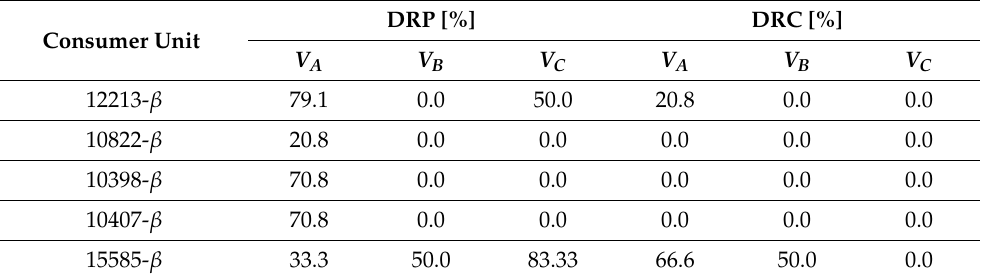
Table 9. Precarious and critical voltage percentages in feeder- β of substation- β with pf = 0.8.